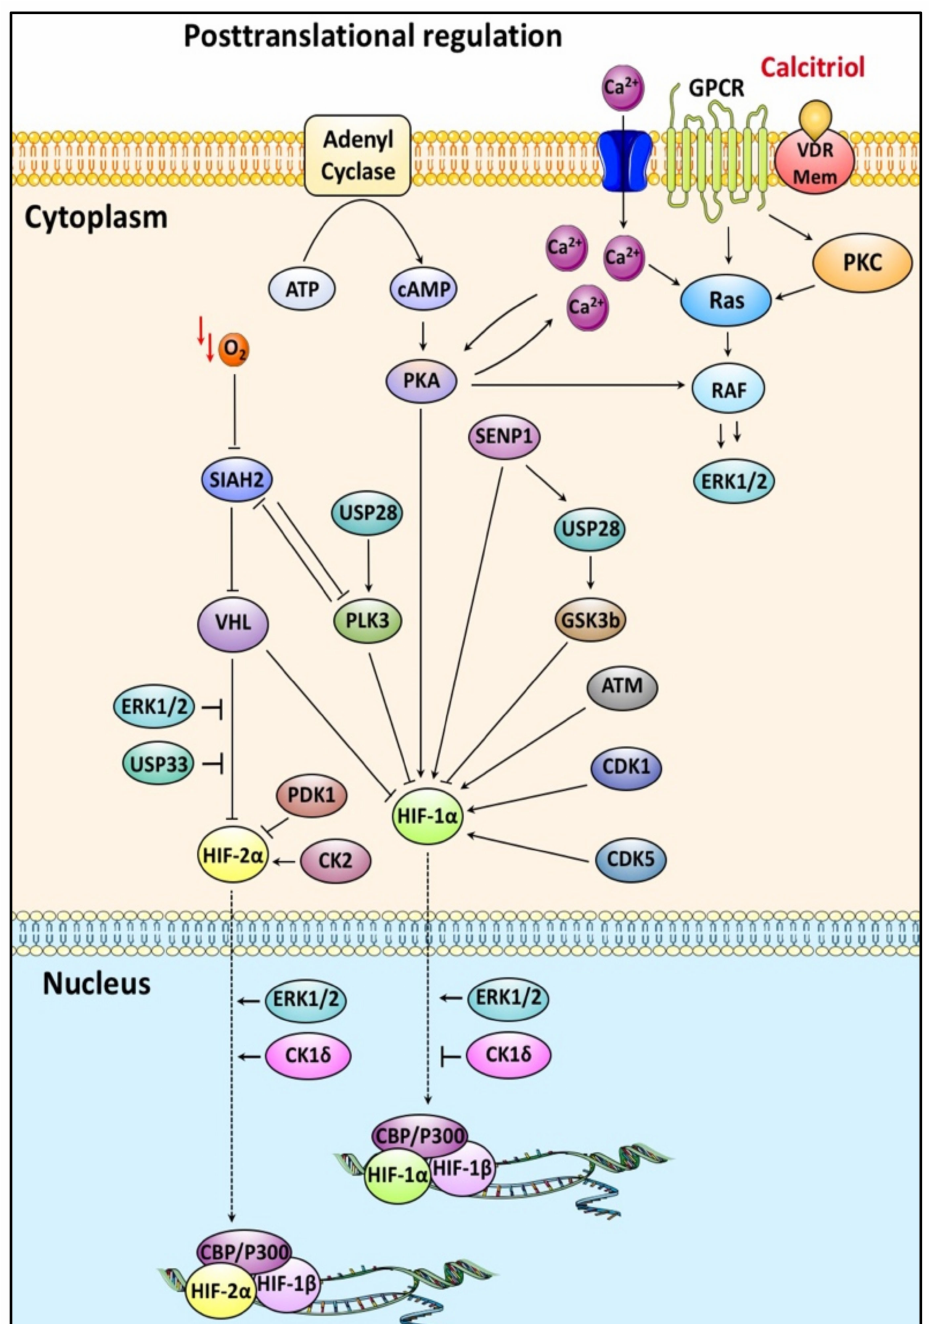
Figure 4. Involvement of calcitriol in the posttranslational regulation of HIF-1/2 α . Both HIF-1/2 α subunits are decorated by multiple phosphorylation events that control their stability, nucleocytoplas- mic shuttling, and transcriptional activity. Calcitriol can indirectly interfere with these modifications by associating with plasma membrane receptors and modulating intracellular signaling cascades. HIF-1 α can be directly phosphorylated by several kinases, including GSK3, PLK3, ATM, PKA, CDKs, which affect its stability. GSK-3 β -mediated phosphorylation targets HIF-1 α on multiple residues and decreases its protein levels in a process regulated by USP28/SENP1 [120–122]. It has been shown that calcitriol reduces the secretion of IL-1 β , which inhibits GSK-3 β [123]. Another HIF-1 α destabilizing modification is mediated by direct HIF-1 α phosphorylation at two sites (S576 and S657) by Polo Like Kinase 3